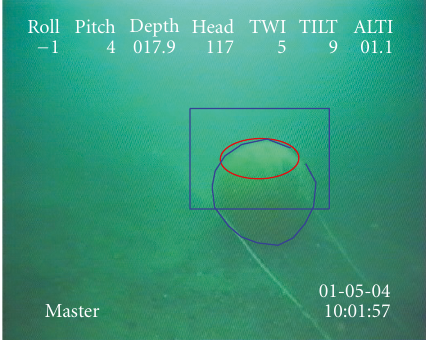
Figure 14: Segmentation of a mine at sea. C good = 0 . 25 and C false = 0.